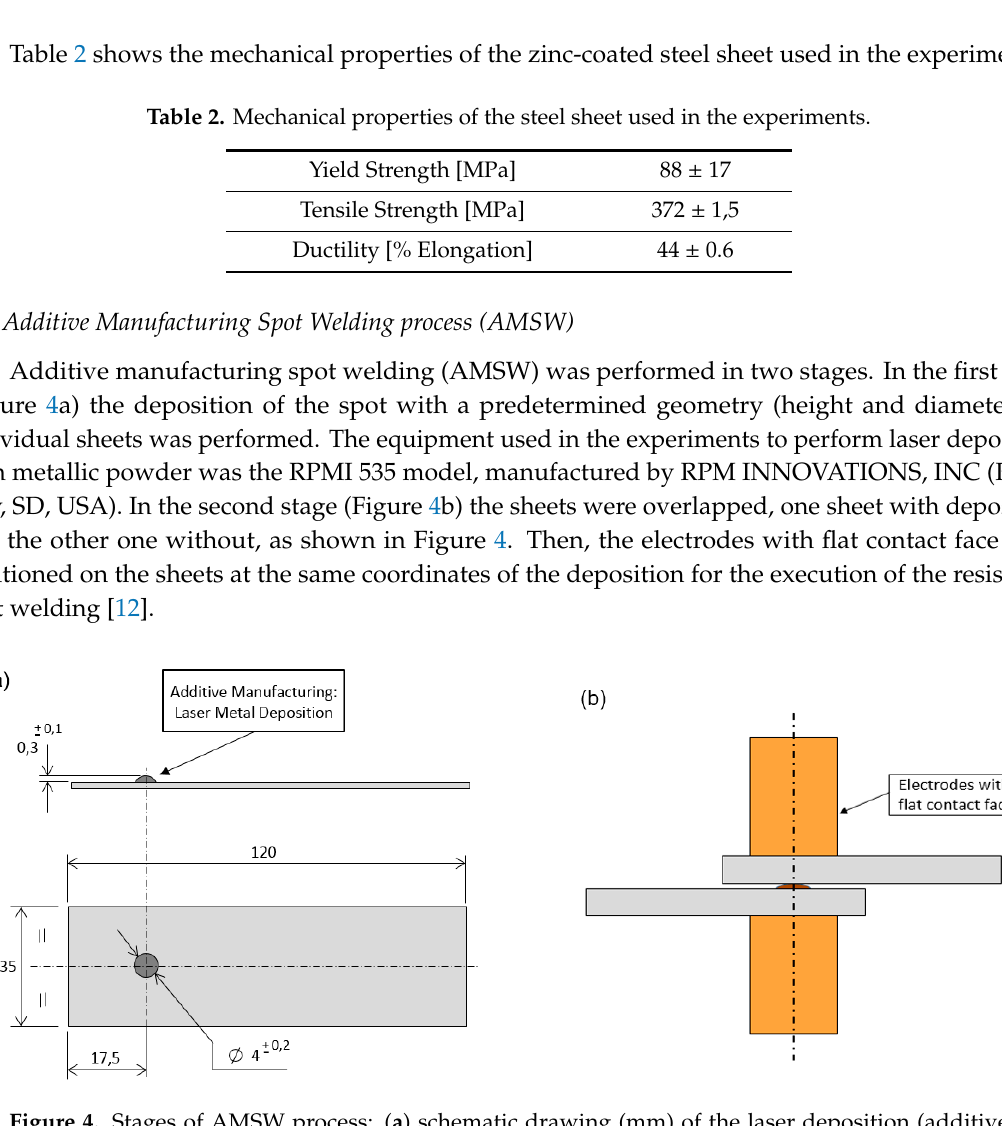
Figure 4. Stages of AMSW process: ( a ) schematic drawing (mm) of the laser deposition (additive manufacturing) using metallic powder (first stage); ( b ) also showing the overlapping sheets, one sheet with deposition and the other one without for the execution of the welding (second stage), respectively. Adapted from